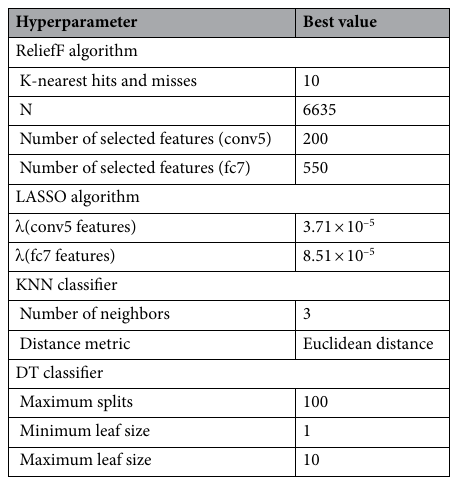
Table 4. The hyperparameters of the proposed technique.